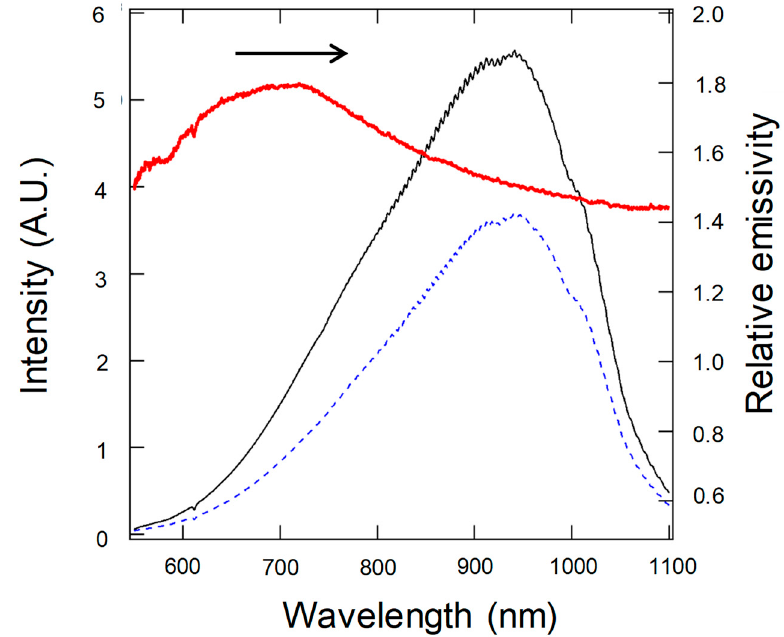
Figure 6. Thermal radiation spectra of the total flux from a microcavity surface (solid line) and flat surface (dotted line). The ratio of total flux (solid red line) is also plotted, representing the enhancement factor.